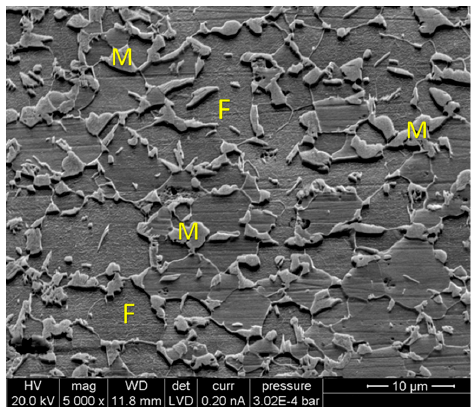
Figure 1. Scanning electron microscopy image of DP600 steel (M: martensite and F: ferrite).